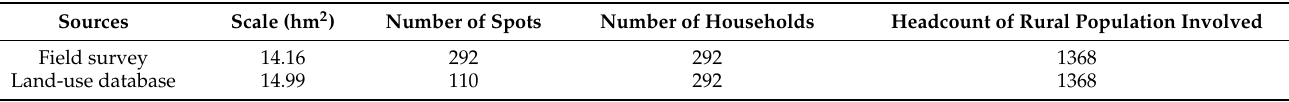
Table 2. Data comparison between the field survey and land-use